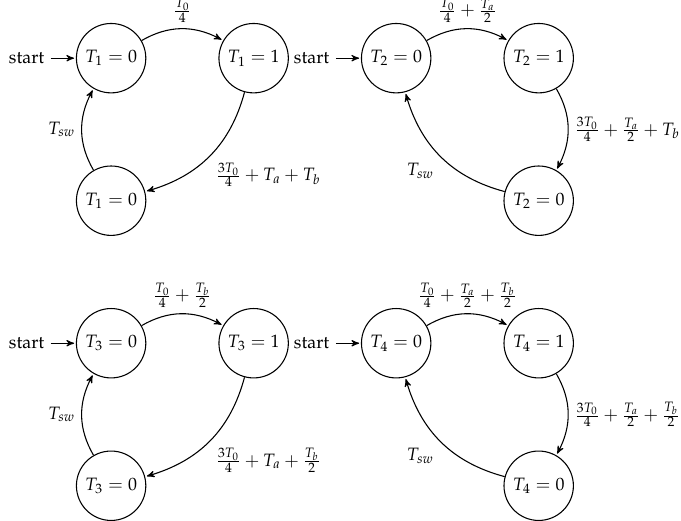
Figure 6. Finite-state machines that model the activation patterns.